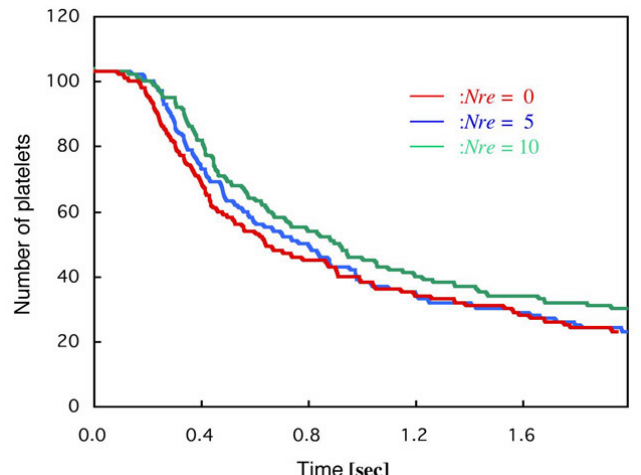
Fig. 7 Time course of the number of platelets which resided above the region of x = 10-50 [ µ m], where the injured surface was assumed. The significant difference in the particle counts between N bind = 0, and 5 eventually became to disappear. In the case of N bind = 10, on the other hand, larger amount of particles stayed on the injured region compared with the other two